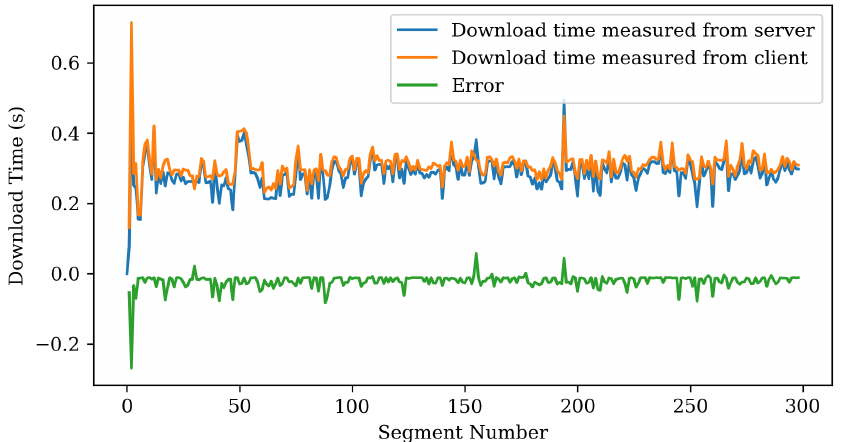
Figure 12. Measurement error between server and client regarding download time in the Chunk